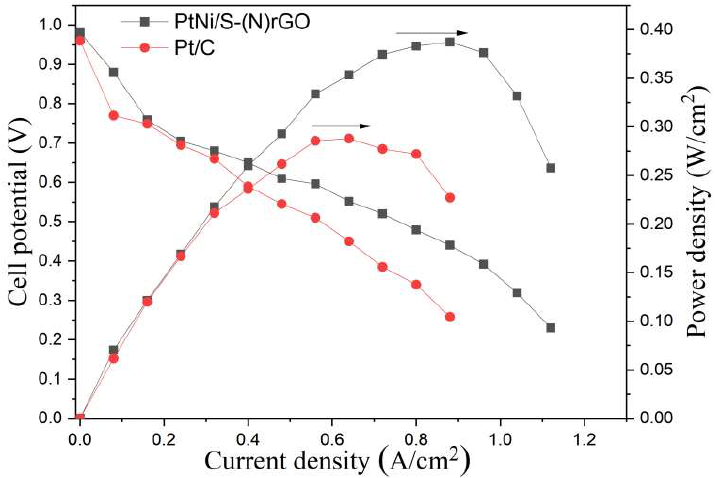
Figure 8. Polarization and power density curves for membrane electrode assembly with PtNi/S-(N)rGO and Pt/C catalysts as the cathode of single cell.